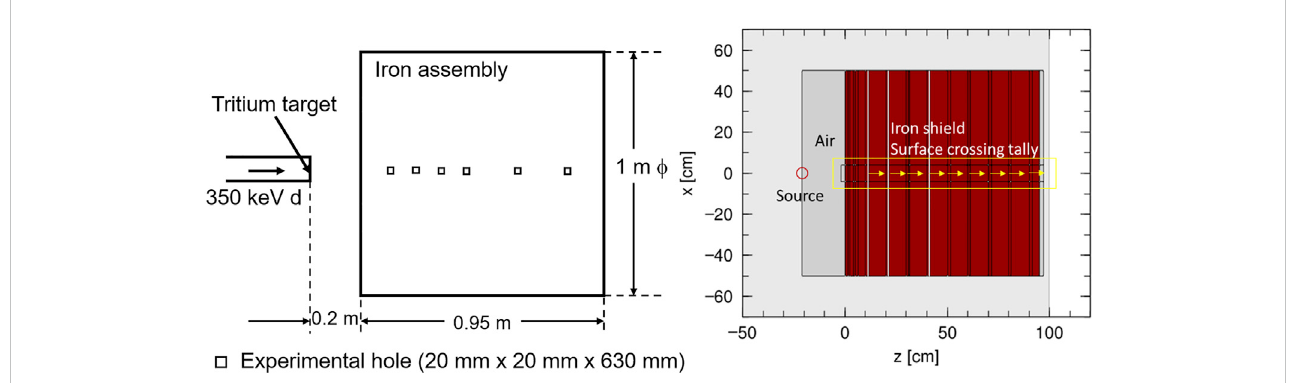
FIGURE 1 Experimental setup (left) and geometry in PHITS (right) for the FNS experiment (Konno et al., 1991; Sub Working Group of Fusion Reactor Physics Subcommittee, 1994). The neutron energy spectra produced by the D-T reaction compiled in the SINBAD (NEA, 2022b) was used as a source